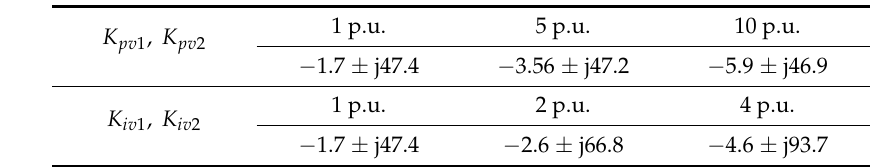
Table 4. Influence of the Proportional and Integral Gains of the DC Voltage Controller of the VSRs on the System Stability ( (cid:2019) (cid:2870)(cid:2868) ,(cid:2019) (cid:2870)(cid:2869) )